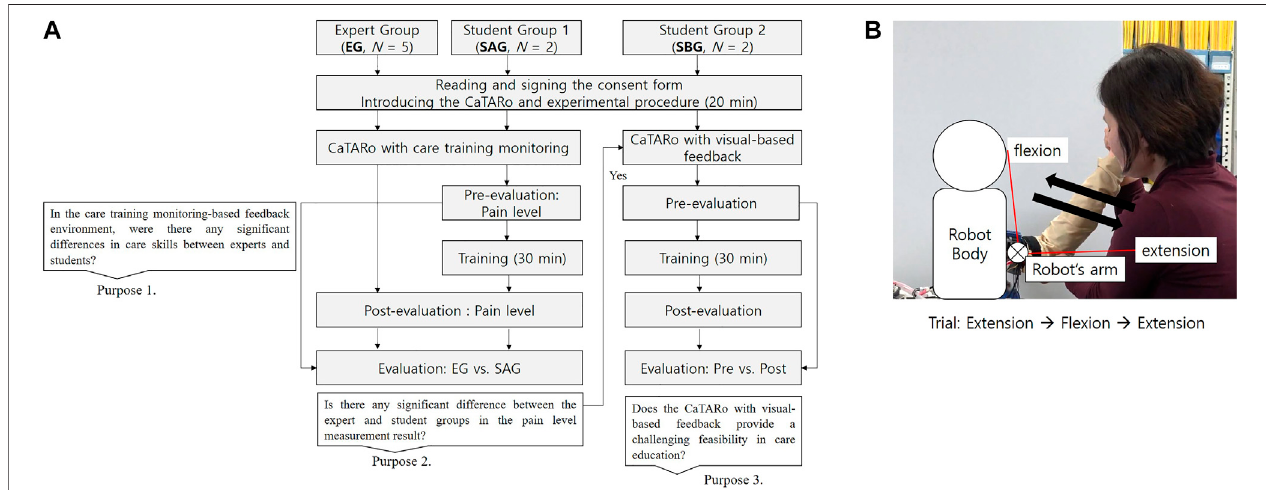
FIGURE 6 | Experimental design and task procedure: (A) experimental procedure and (B) care task procedure.